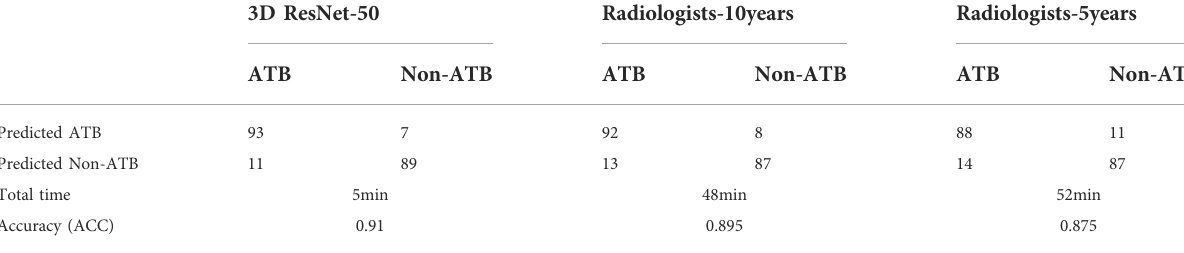
TABLE 4 Experienced radiologist-machine diagnosis ability competition in the external testing